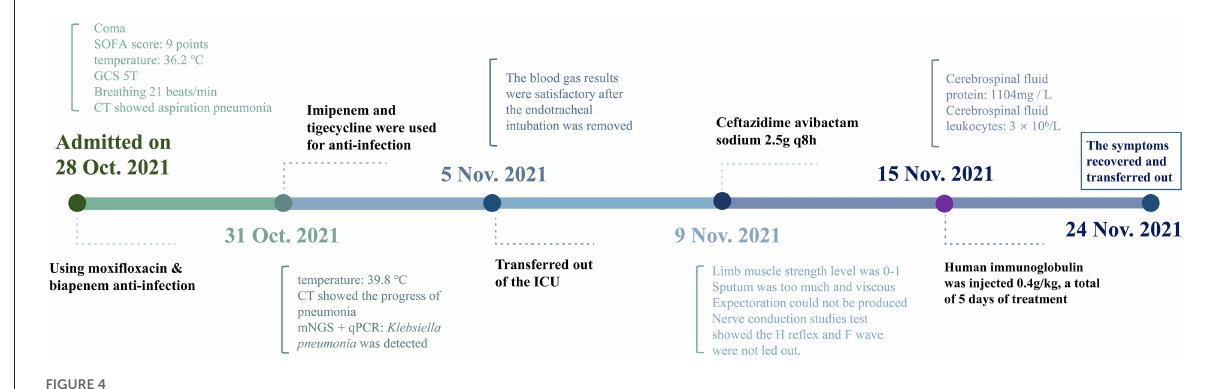
FIGURE4 Diagnosis and treatment timeline of the